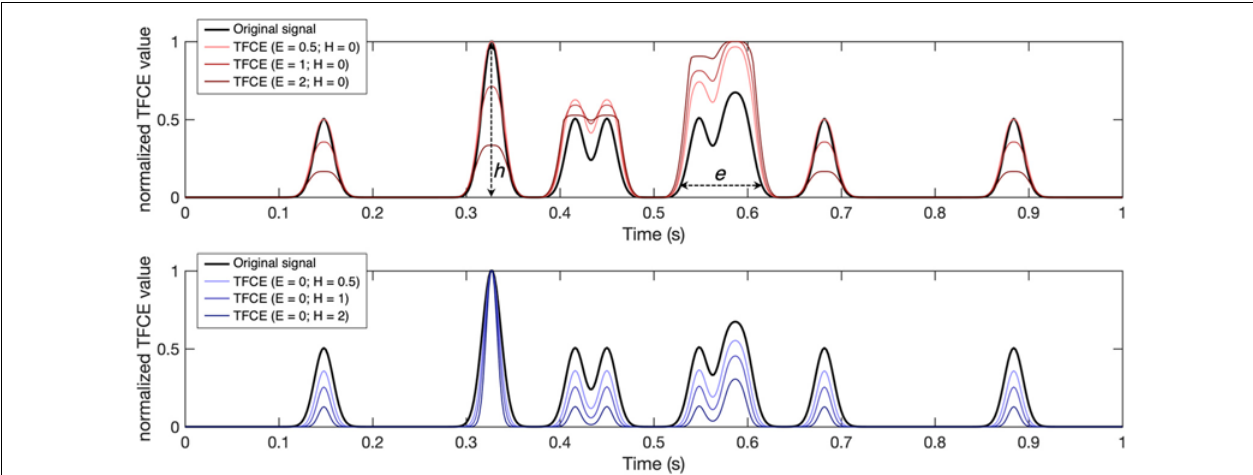
FIGURE 3 | Examples of time series filtered using the threshold free cluster enhancement (TFCE) algorithm with different combinations of parameters. A larger E weighs more the components of the original signal with a longer temporal extent ( e ), defined as the time interval where the signal is consistently above a predefined minimum (h0). Larger H , conversely, weighs more the highest components of the signal in terms of intensity ( h ). Note that the TFCE values here are normalized between 0 and 1 for visualization purposes